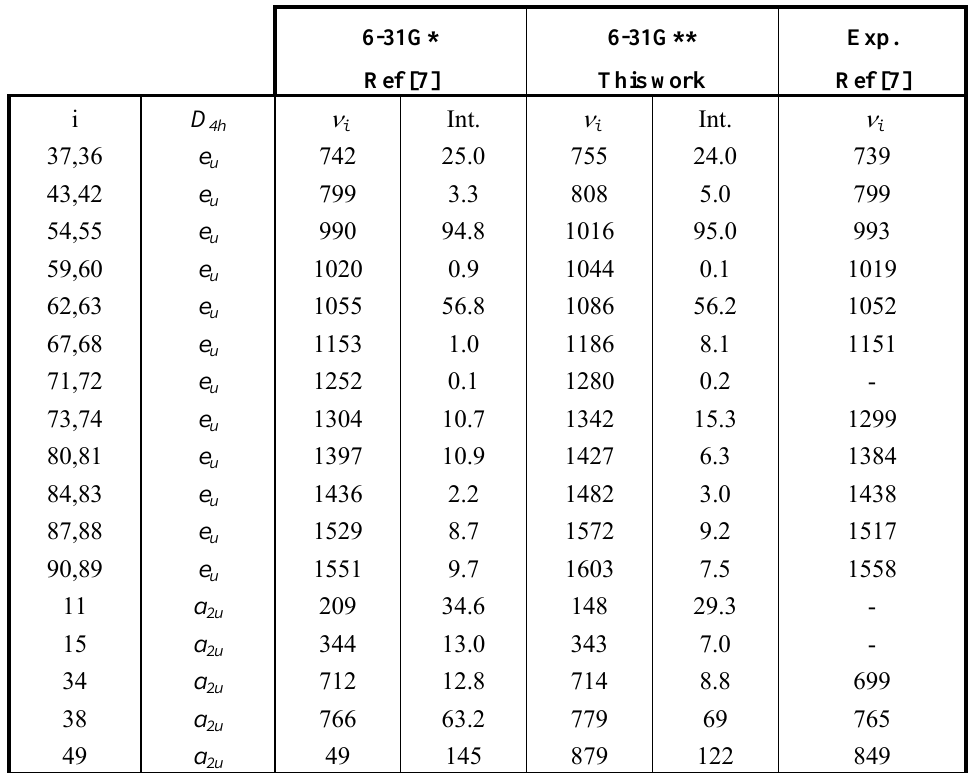
Table 4. The part of the infra-red spectrum of Zn-porphyrin calculated employing the B3LYP DFT method. “Int.” is the IR absorption intensity (km/mol), “  (cm -1